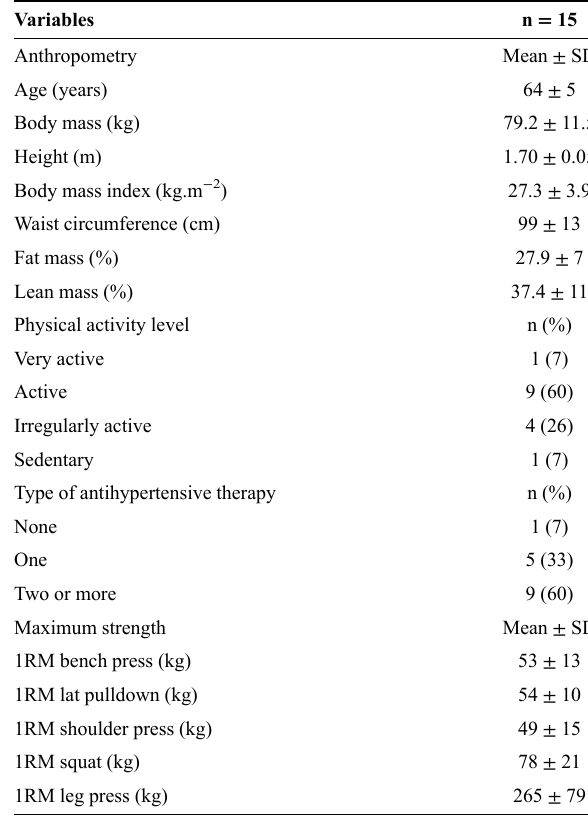
Table 1 - General characteristics of the participants.